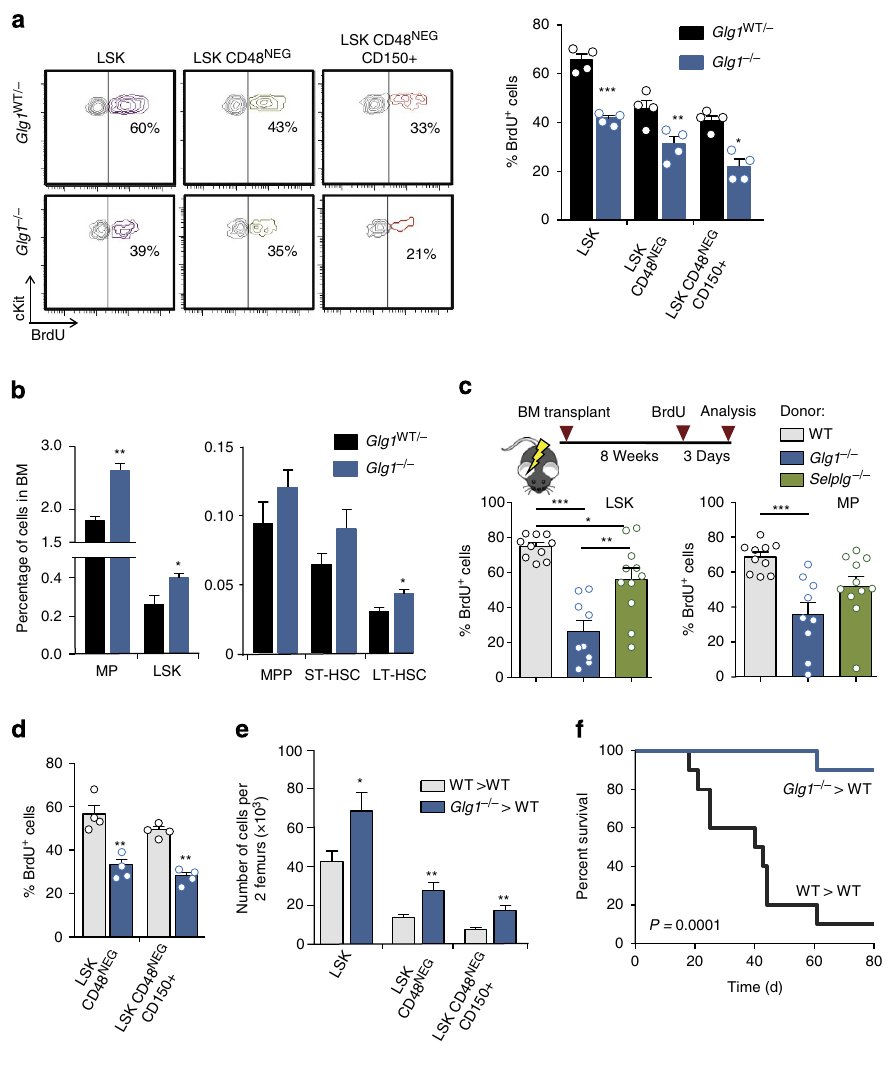
Figure 1 | ESL-1 controls the proliferation and numbers of HSPC in the bone marrow. ( a ) Representative plots of BrdU proliferation assays gated on Lineage NEG cKit HI Sca1 þ (LSK) cells, LSK CD48 NEG and LSK CD48 NEG CD150 þ cells in Glg1 (cid:2) / (cid:2) and Glg1 WT/ (cid:2) littermates. Right, percentage of BrdU-incorporating cells; n ¼ 4. ( b ) Percentage of the indicated populations in the BM of Glg1 (cid:2) / (cid:2) and Glg1 WT/ (cid:2) littermates; n ¼ 5. ( c ) Experimental design and percentage of BrdU incorporation in WT, Glg1 (cid:2) / (cid:2) and Selplg1 (cid:2) / (cid:2) progenitors in transplanted WT mice; n ¼ 9–11. ( d ) Percentage of BrdU-incorporating cells in the indicated HSPC populations from WT and Glg1 (cid:2) / (cid:2) -transplanted mice; n ¼ 4. ( e ) Absolute numbers of the indicated populations in two femurs of WT and Glg1 (cid:2) / (cid:2) transplanted mice; n ¼ 7. ( f ) Survival curves of mice transplanted with WT or Glg1 (cid:2) / (cid:2) BM cells after repeated injection of 5-FU; n ¼ 10. * P o 0.05; ** P o 0.01; *** P o 0.005 as determined by Student’s t -test for two data sets, or one-way analysis of variance with Turkey’s test for multiple data sets. In f , comparison of survivals was performed using the Log-rank test. Each circle represents a mouse. Bars show mean ±